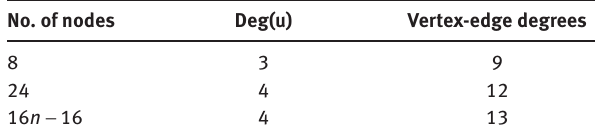
Table 5: Nodes partitioning of (